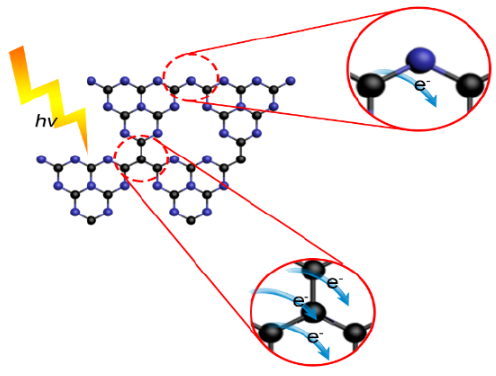
Figure 9. Band structure of the C 3 N 4 NS and 0.4 C ‐ C 3 N 4 NS.